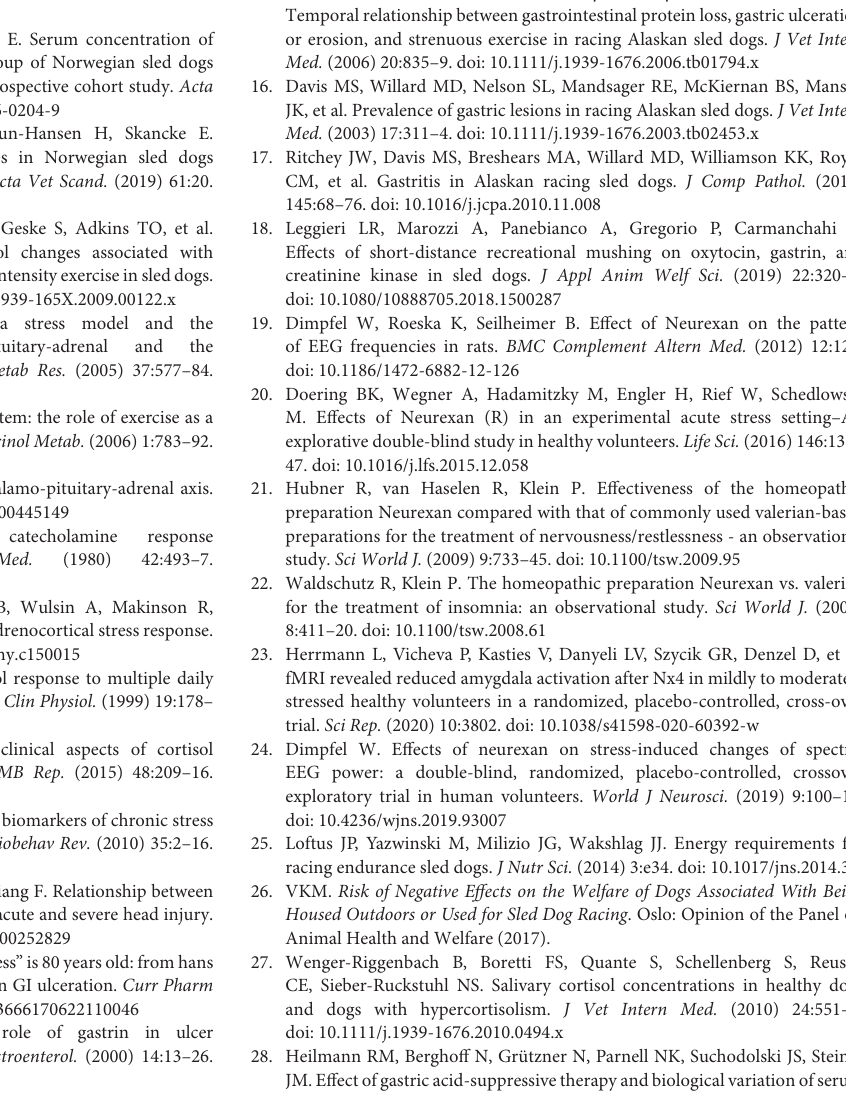
Supplementary Figure 1 | Comparing plasma Cortisol levels (ng/ml) from the start of the training season to the middle of the training season. The data ( n = 10) are displayed as boxplot showing the first (25%), the median (50%), and the third quartile (75%). The whiskers are displaying values within 1.5 times the IQR. Outliers are plotted as individual points. # p = 0.0034. Supplementary Figure 2 | Comparing plasma gastrin levels (pg/ml) from the start of the training season to the middle of the training season. The data ( n = 10) are displayed as boxplot showing the first (25%), the median (50%), and the third quartile (75%). The whiskers are displaying values within 1.5 times the IQR. Outliers are plotted as individual points. # p < 0.0001. Supplementary Figure 3 | Comparing leucocytes (G/L) from the start of the training season to the middle of the training season. The data ( n = 10) are displayed as boxplot showing the first (25%), the median (50%), and the third quartile (75%). The whiskers are displaying values within 1.5 times the IQR. Outliers are plotted as individual points. # p =